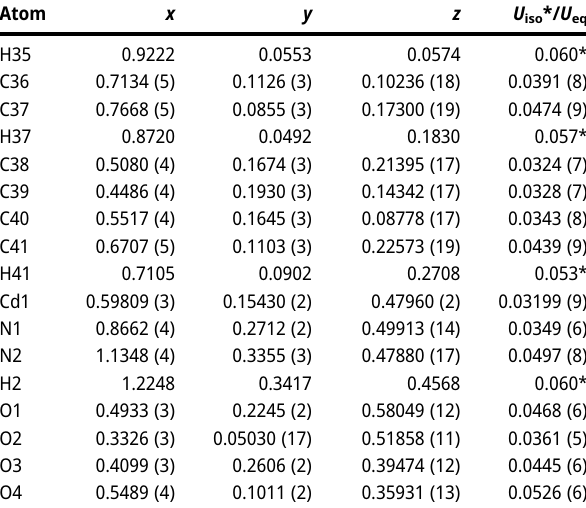
Table  : Fractional atomic coordinates and isotropic or equivalent isotropic displacement parameters (Å 